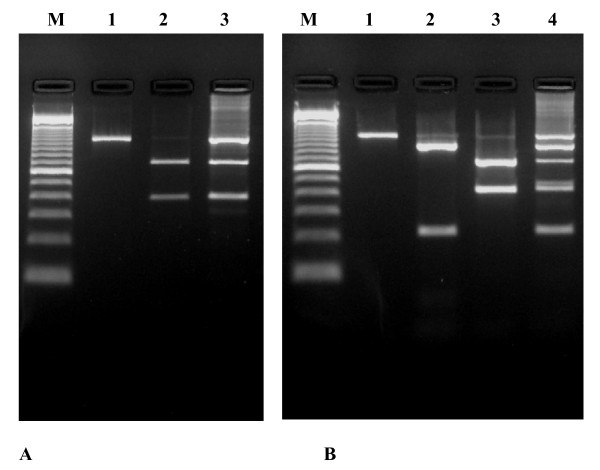
PCR-RFLP analysis of the pre-S/S genomic region. (A), EcoRI restriction endonuclease digestion. Lane 1, PCR products without EcoRI site (pattern predicted for genotype G). Lane 2, PCR products containing one EcoRI site (pattern deduced for most HBV genotype A isolates). Lane 3, PCR products derived from sample 09-hgg. (B), digestion with BamHI. Lane 1, PCR products without BamHI site (pattern predicted for genotype G). Lane 2, PCR products containing a BamHI restriction site at nt 491 (pattern predicted for genotypes B and C and some genotype A isolates). Lane 3, PCR products containing a BamHI site at nt 28 (subgenotype Aa and genotype G). Lane 4, PCR products derived from sample 09-hgg.